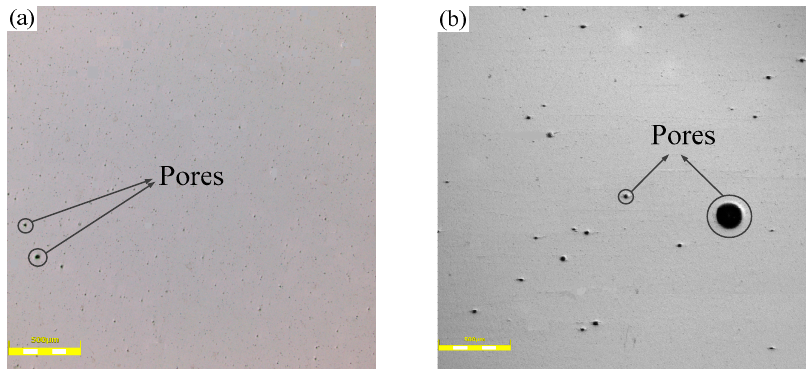
Figure 4. The macroscopic feature of ( a ) No.1 alloy and ( b ) No.2 alloy.